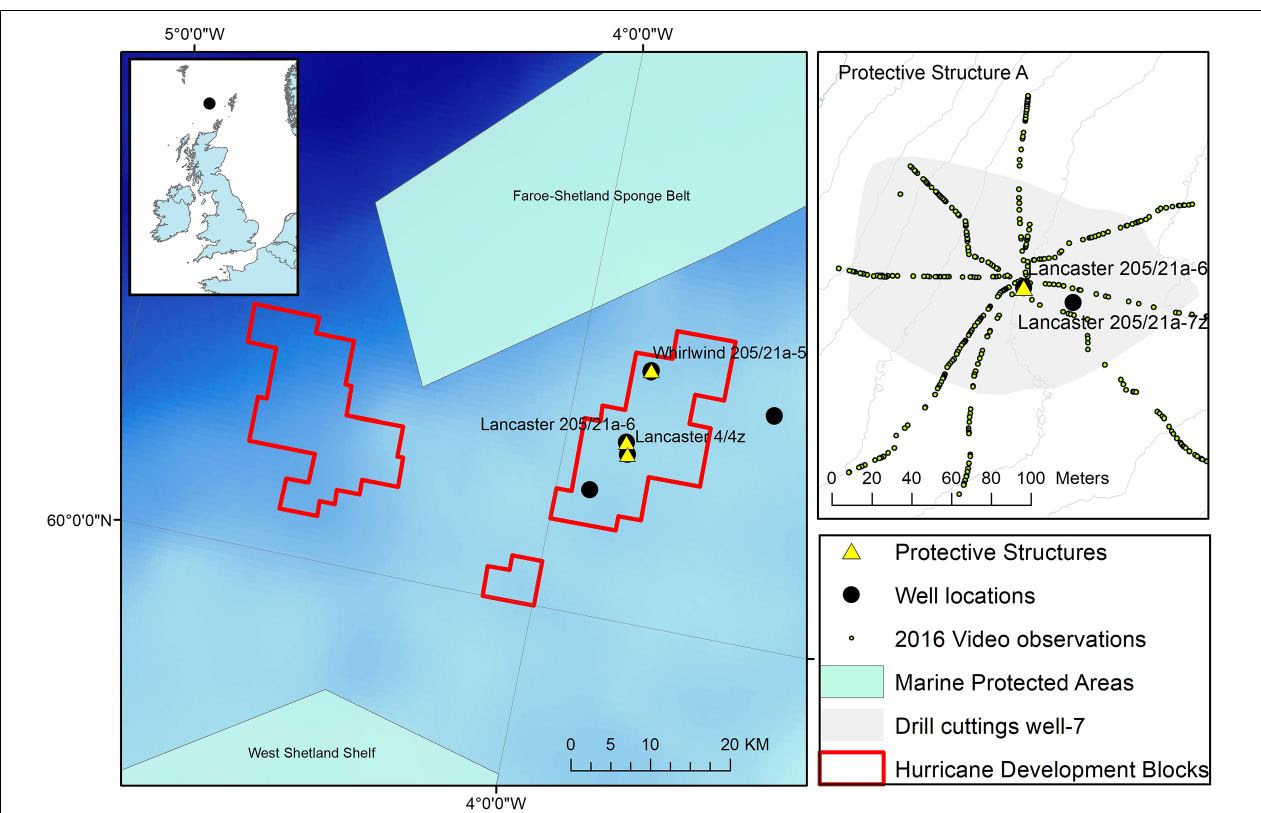
FIGURE 1 | Location of the protective structure (Lancaster 205/21a-6) investigated here. Other observations at the location are also shown including extent of drill cuttings around well after drilling Lancaster 205-21a-7z and the location of ROV video observations. Inset: Hurricane Energy well locations west of Shetland and Marine Protected areas including the Faroe-Shetland Sponge belt Nature Conservation Marine Protected Area (NCMPA)